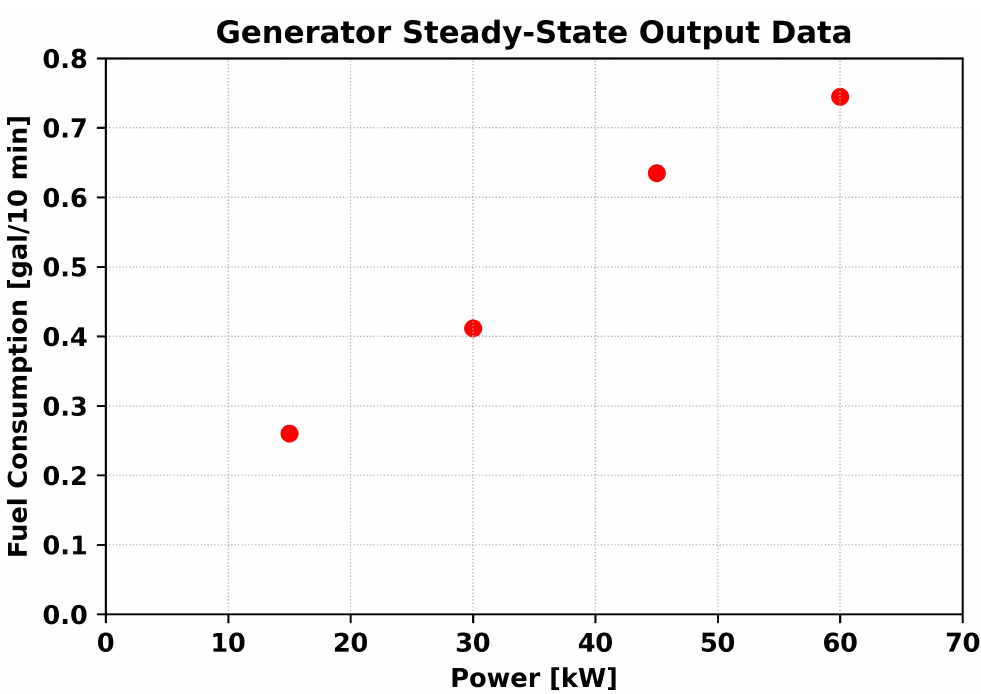
Figure 2. Steady-state fuel consumption data from a 60 kW AMMPS generator at four distinct operating regions obtained from previous studies